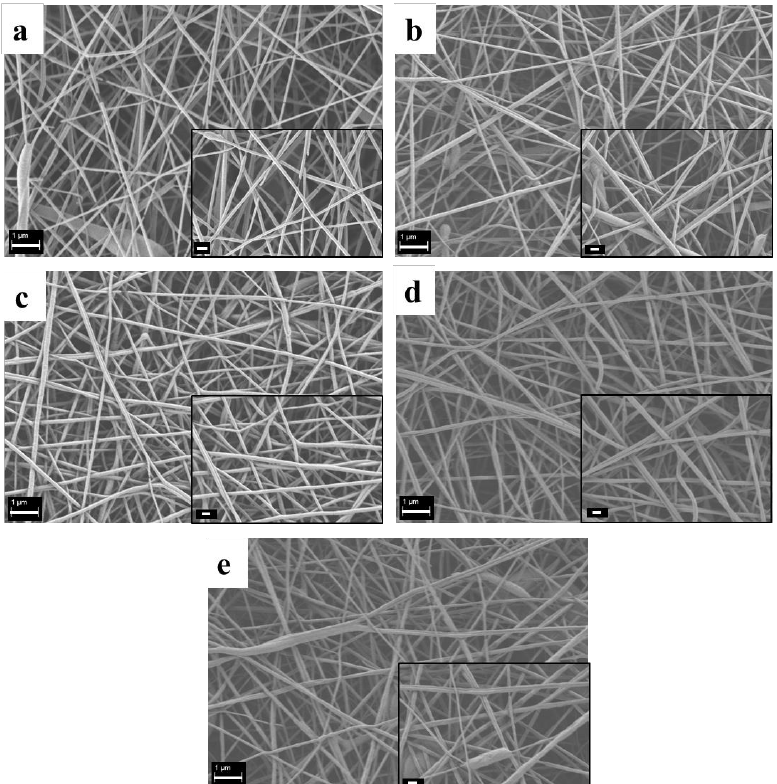
Figure 5. SEM analysis of neat PCL electrospun fibers obtained by setting different values of relative humidity (RH) : 25% ( a ), 30% ( b ), 40% ( c ), 50% ( d ) and 60% ( e ). Common scale bar 1μm, higher magnification micrographs in the insets with common scale bar of 200 nm.